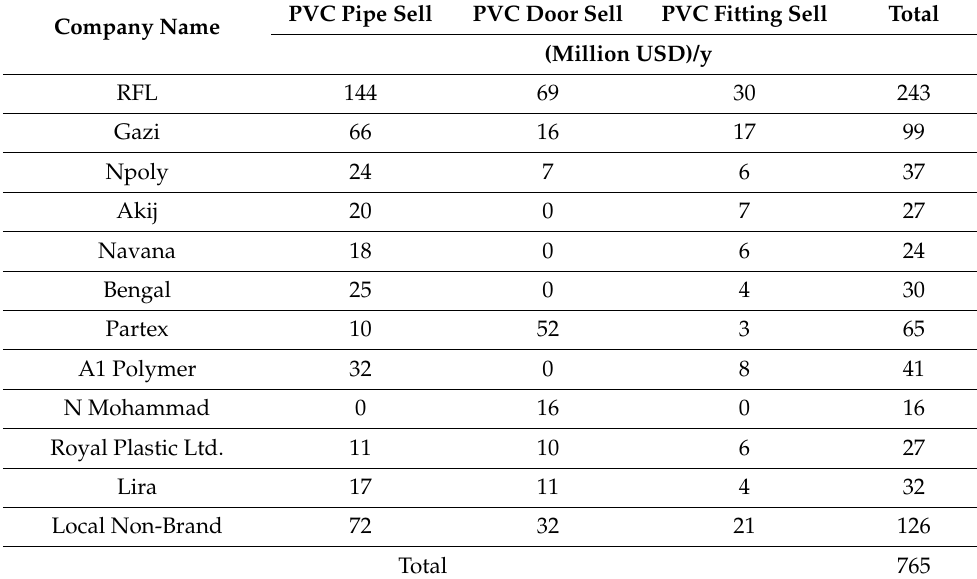
Table 3. PVC materials market scenario in